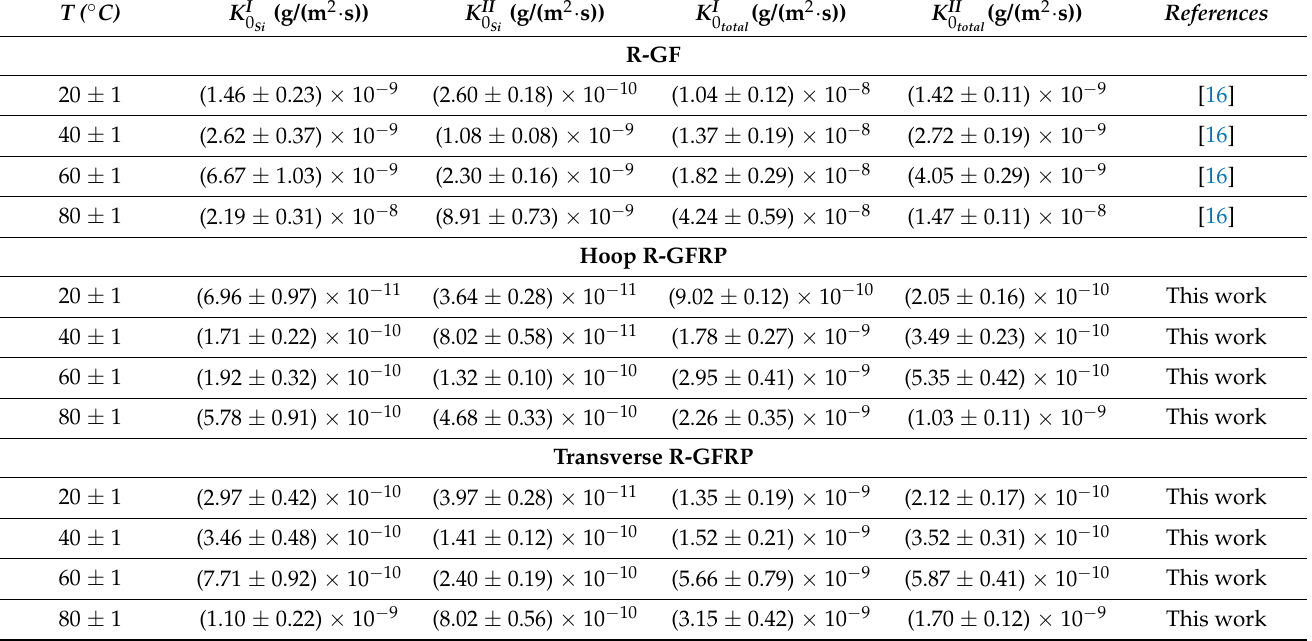
Table 3. The glass dissolution rate constants were obtained via regression of the experimental data of GFRPs using the DCZOK model for Si and total mass loss at pH 5.65 and various temperatures for both hoop and transverse